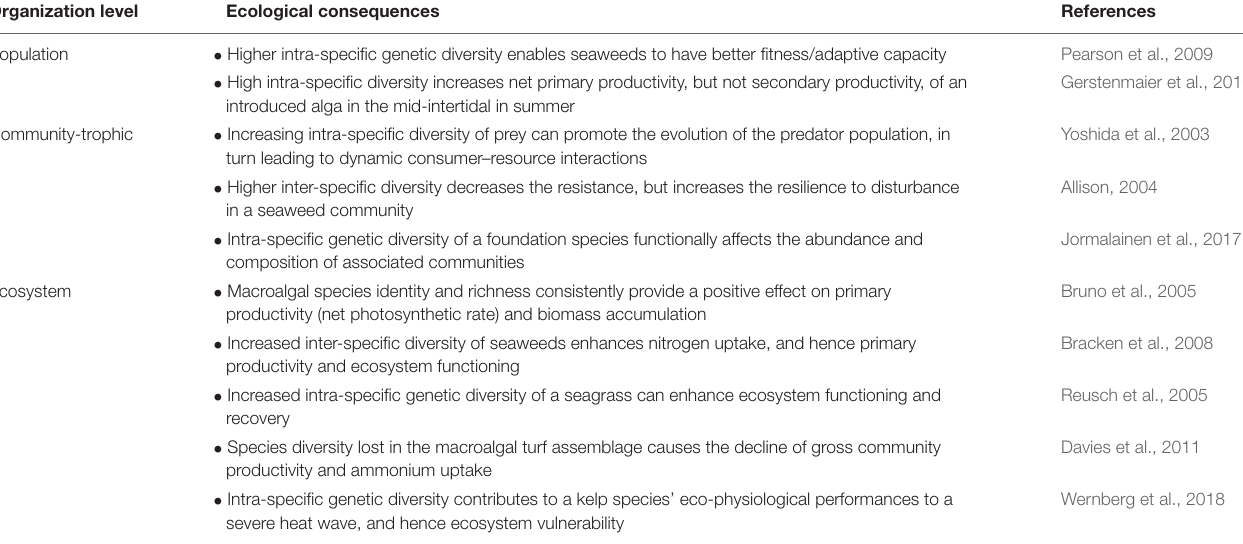
TABLE 3 | Summary of studies illustrating the ecological consequences of intra-specific or inter-specific genetic diversity at different organization levels in marine